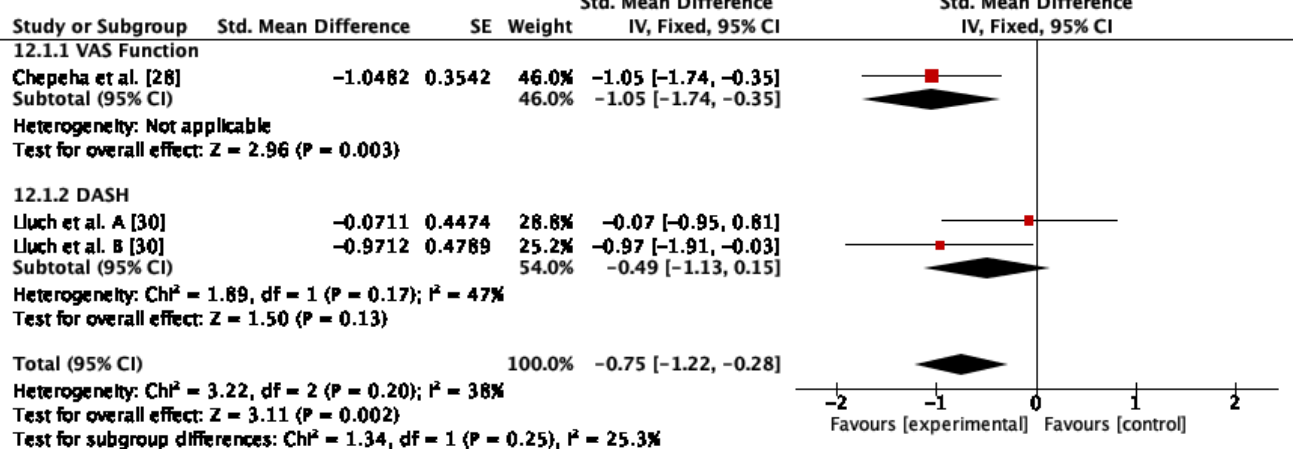
Figure 9. Forest plot of physical function for conservative therapy versus control/sham and conservative therapy versus other conservative therapy. Lluch et al. A. compared manual therapy versus control intervention. Lluch et al. B compared the manual contact versus control intervention.